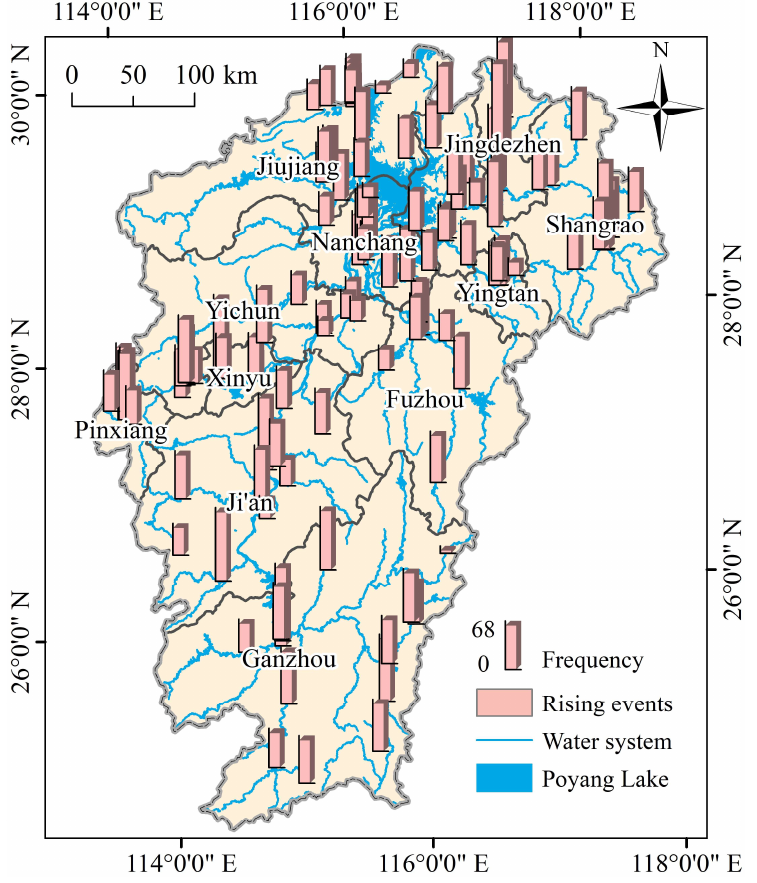
Figure 4. Distribution of groundwater level rising events in the PLB from 2018 to 2020.